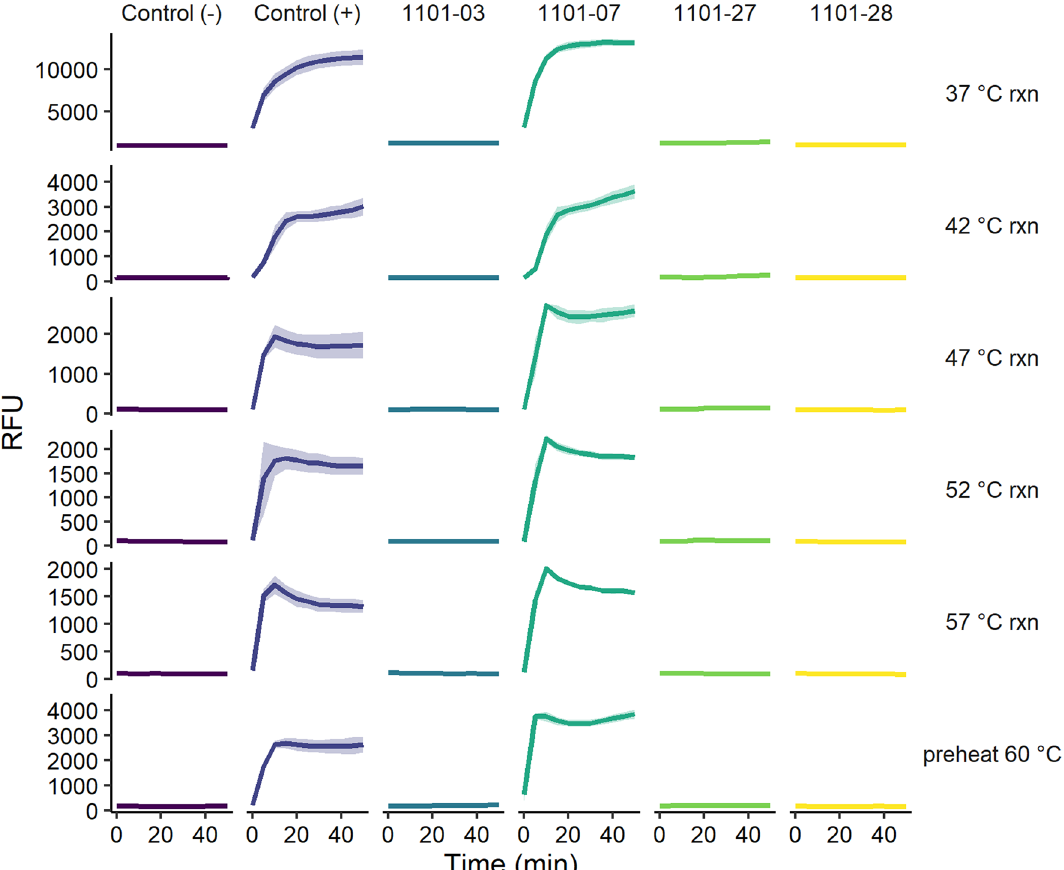
Figure 5. Fluorescence traces of Cas13a experimental variations with increased reaction temperatures (37 °C, 42 °C, 47 °C, 52 °C, 57 °C rxn) and pre-heating of Cas13a + crRNA before addition of target RNA (preheat 60 °C). Solid lines represent mean and shaded regions represent standard deviation (n = 3) of Cas13a activation with selected crRNAs. “Control ( −)” samples contained no crRNA and “Control ( +)” contained the internal standard 0056–07